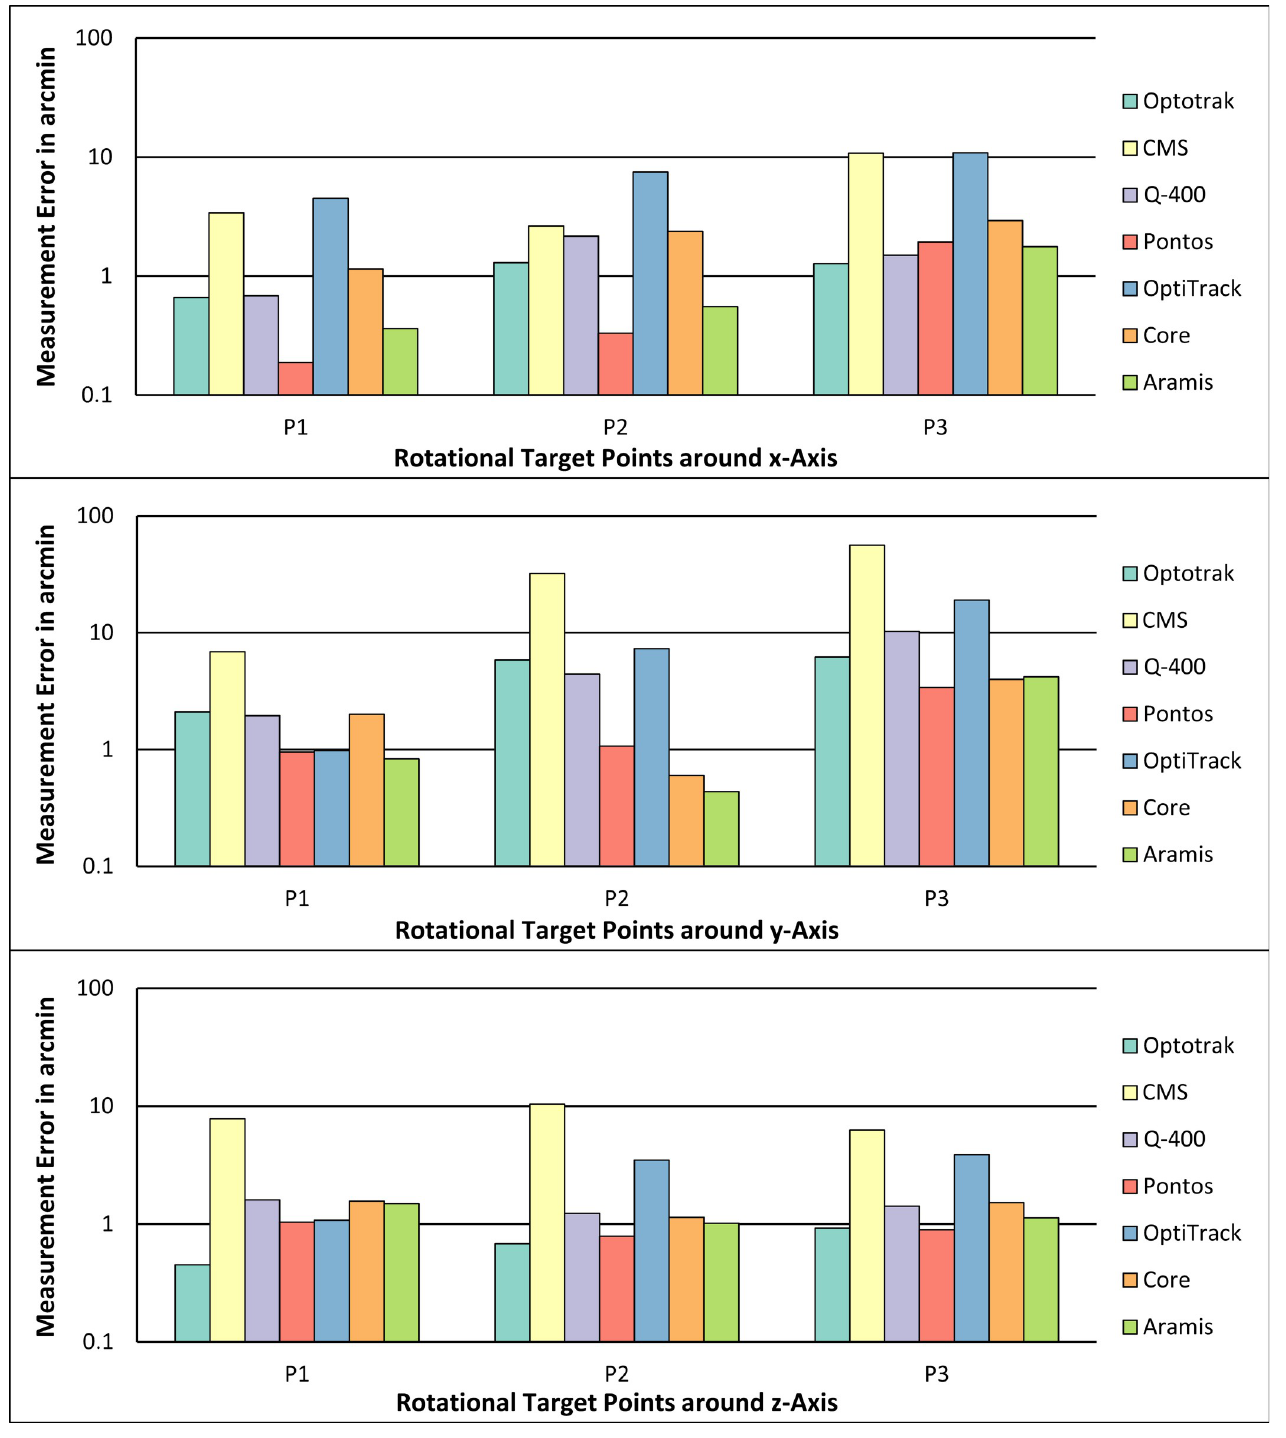
Fig 7. Measurement errors of the accuracy measurements of the translational motions in x-direction (top diagram), y-direction (middle diagram) and z- direction (bottom diagram) for the seven measurement systems using the manual reference device.